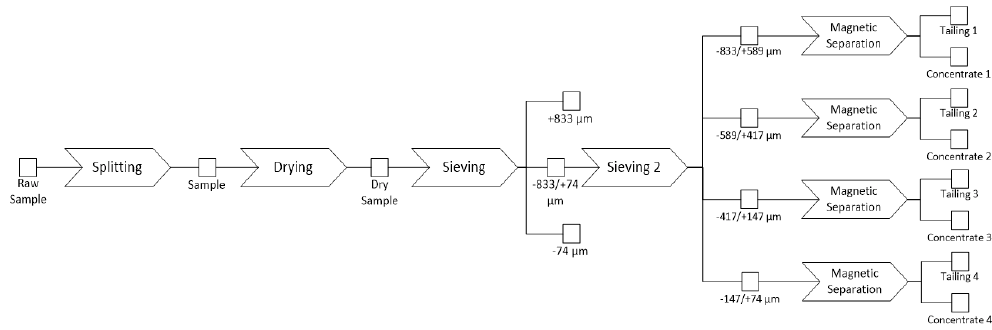
Figure 3. Laboratory workflow. Arrow-shaped boxes represent processes, and square boxes represent the input and outputs obtained from the respective process.